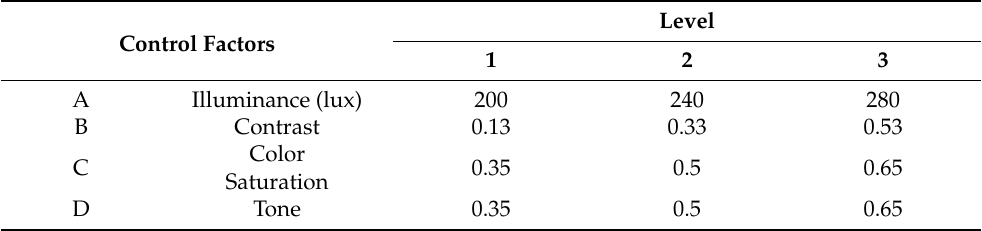
Table 1. Control Factors & Levels of Control Factors.